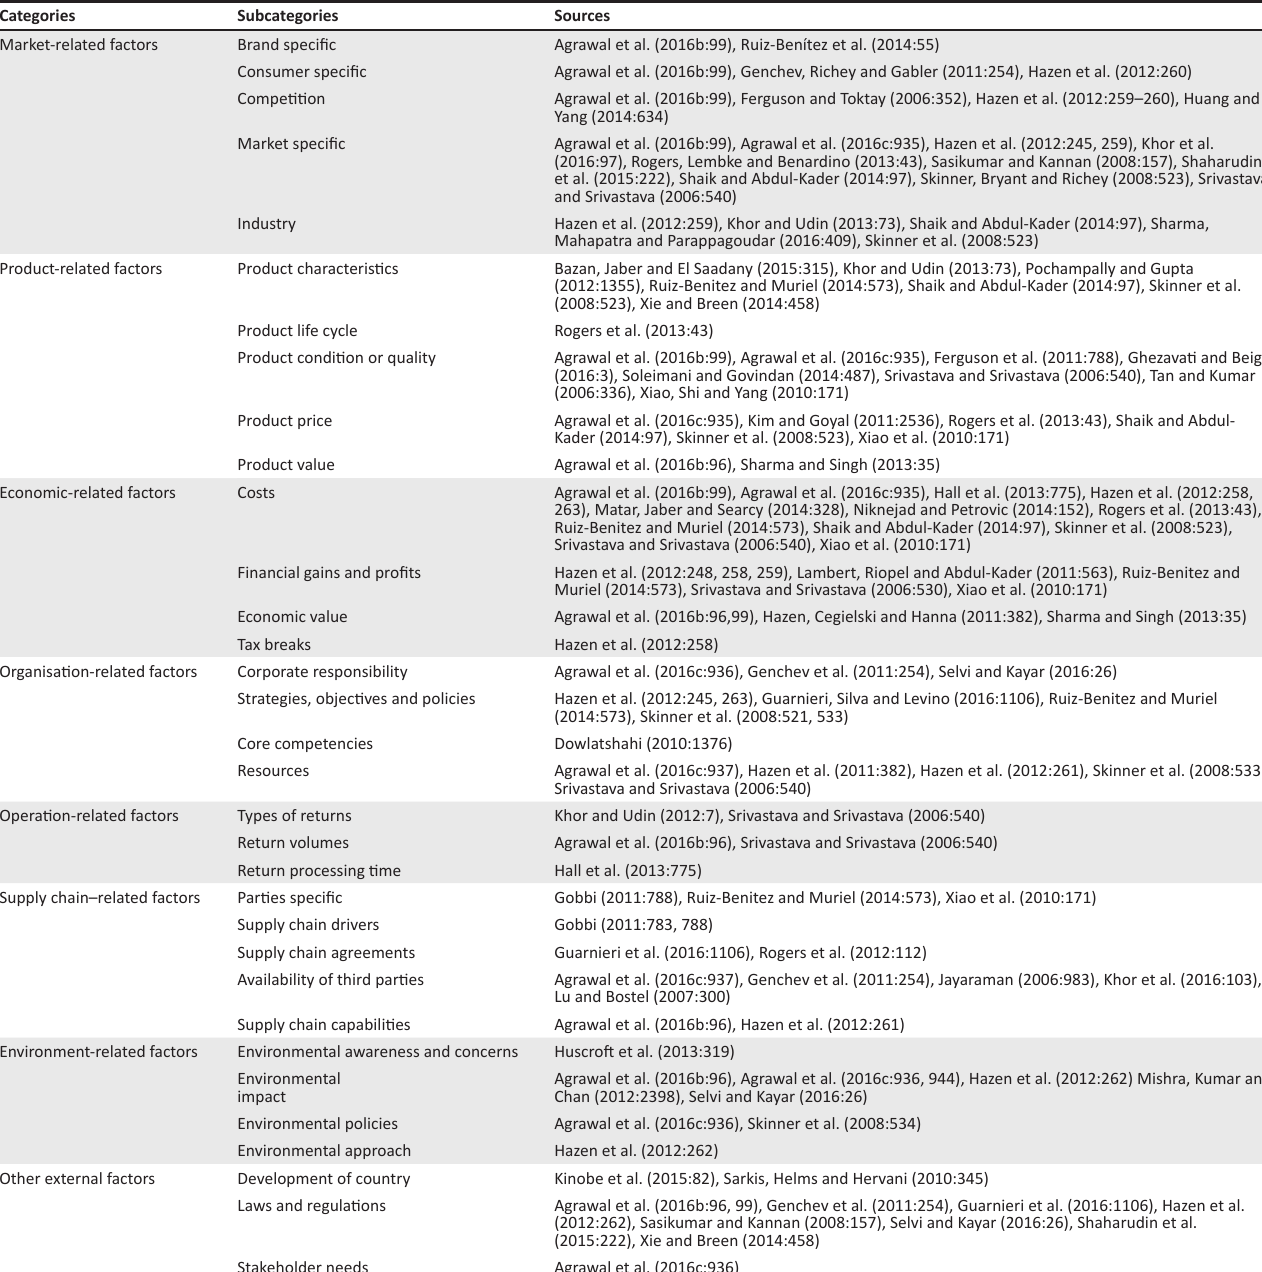
TABLE 2: Categories and subcategories of factors that influence disposition